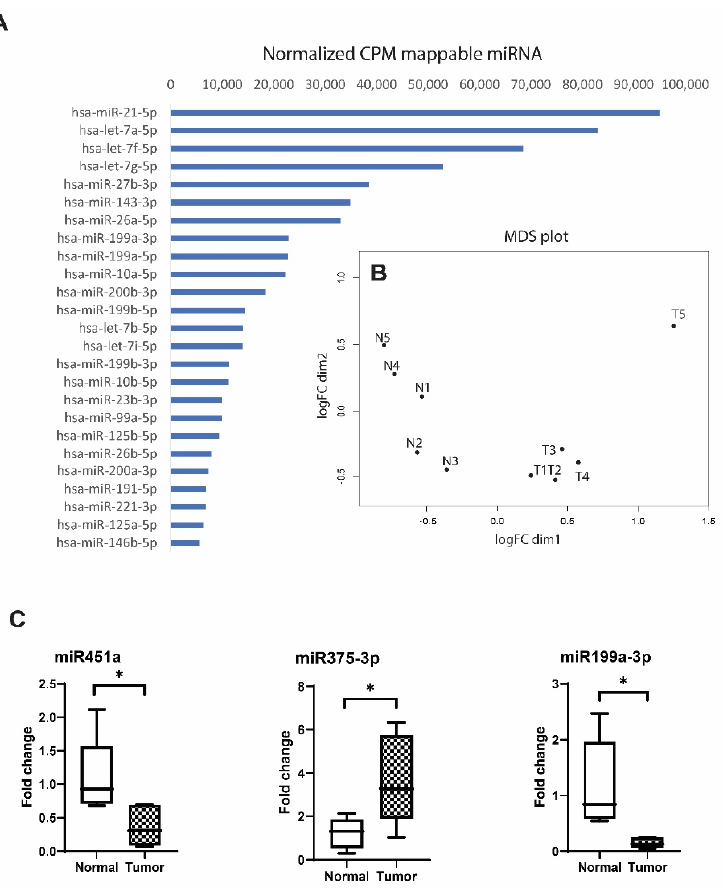
Figure 4. Analysis of miRNAs in EVs isolated from the UA of EOC patients and healthy individuals. ( А ) The 30 most abundant miRNAs among UA exosomal small RNAs (normalized CPM mappable miRNAs). ( В ) MDS plot (multidimensional scaling plot) shows variations among miRNA differen- tial expression in the analyzed samples, and the distance between sample labels indicates a